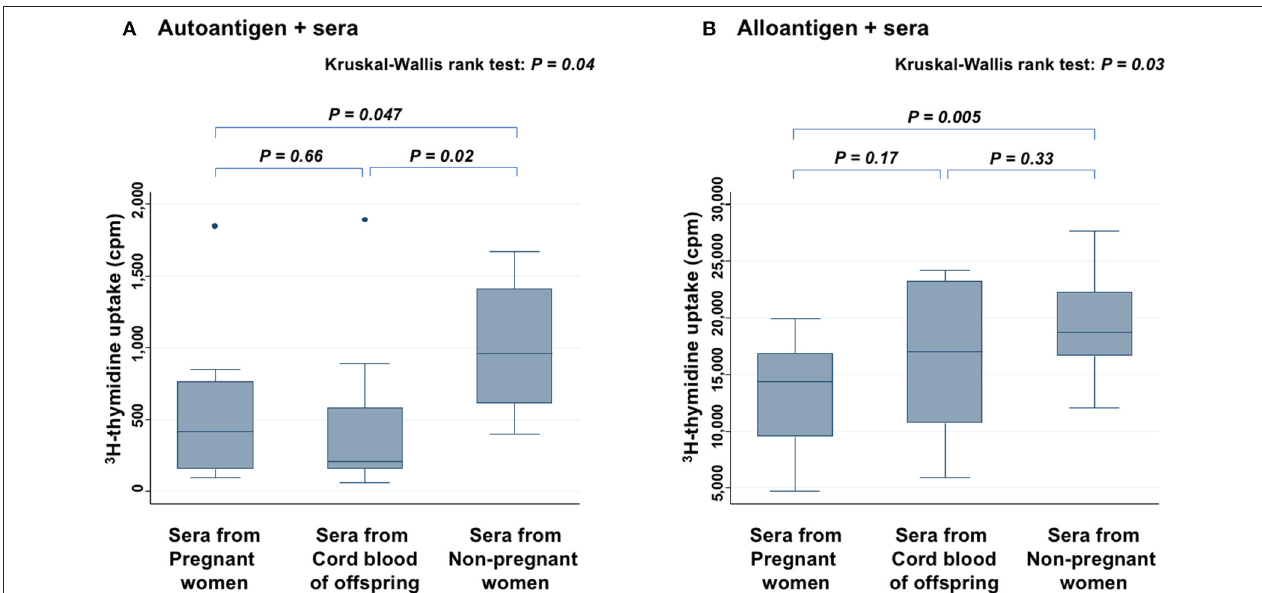
FIGURE 3 | Mixed lymphocyte culture assays in the presence of autoantigen (A) and alloantigen (B) . Levels of 3 H-thymidine uptake of peripheral blood mononuclear cells (PBMCs) are compared among sera from PW, offspring, and non-PW. The Kruskal-Wallis rank test (KW test) was used for comparisons among three groups. The Mann-Whitney test was used to compare two groups.